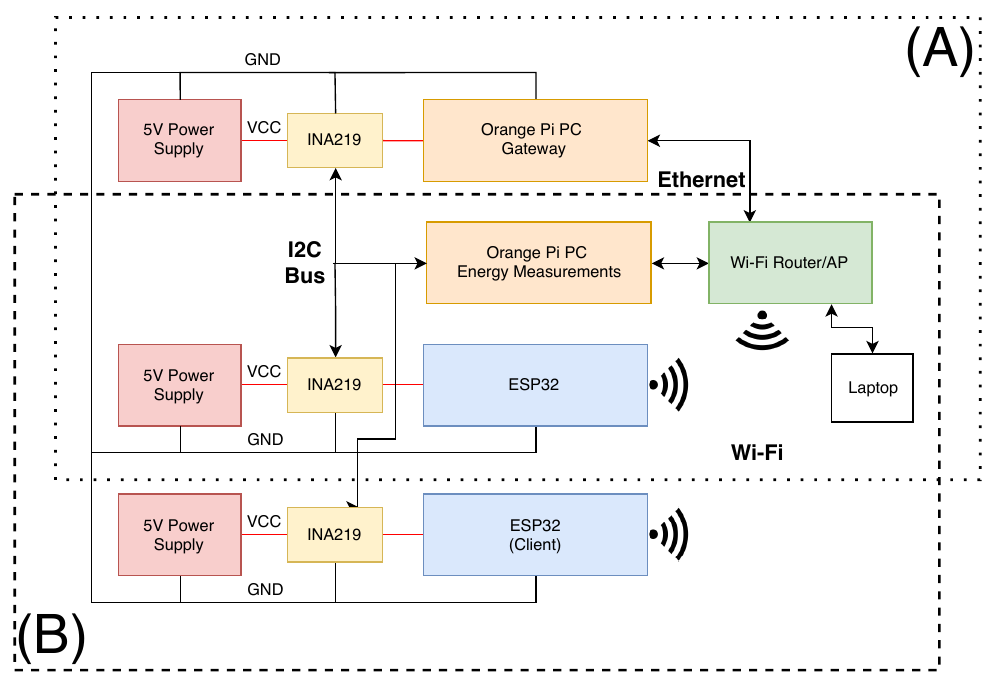
Figure 3. Testbed architecture configurations. Fog Gateway to Mist End-Device ( A ) and Mist End-Device to Mist End-Device ( B ).